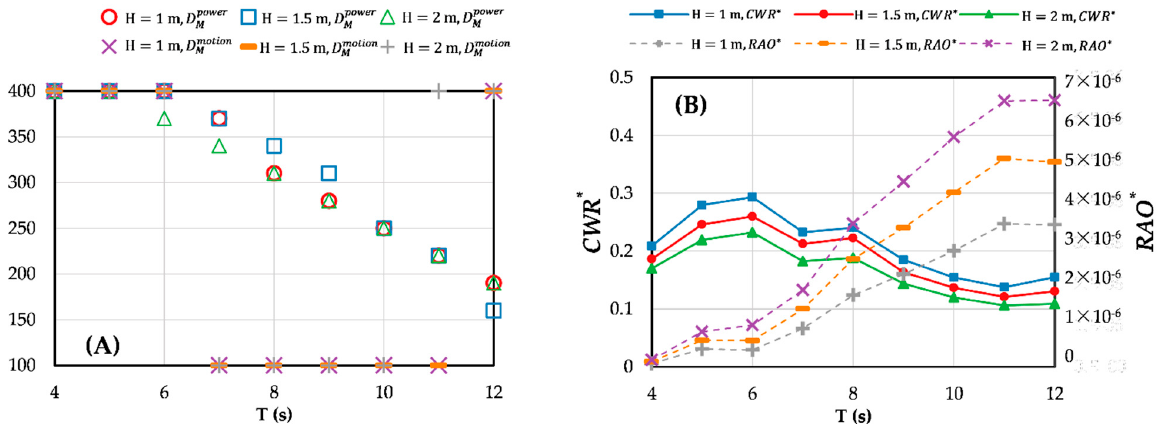
Figure 13. Influence of displacement of hydraulic motor on the performance of the hybrid system under wave height of 1.5 m. ( A ) Variation of CWR. ( B ) Variation of pitch motion RAO.